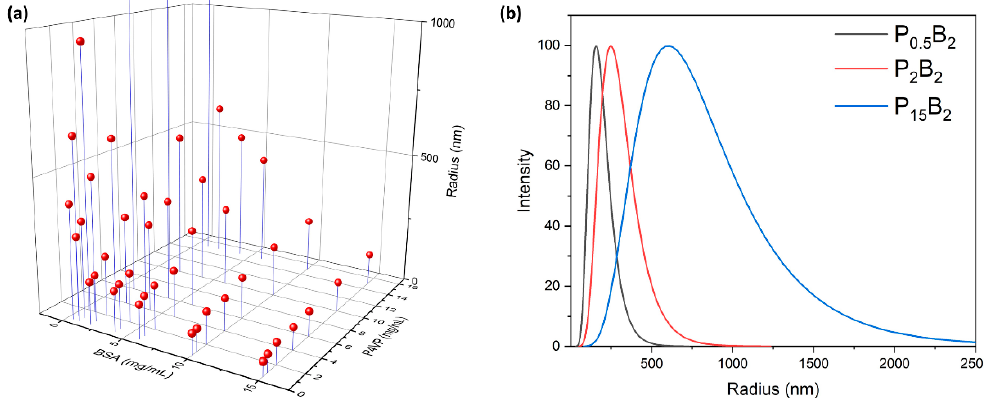
Figure 1. ( a ) Plot of the DLS mean particle size for reactions with each of the varying P4VP and BSA concentrations. ( b ) DLS lognormal distribution for three reactions increasing in P4VP concentration.